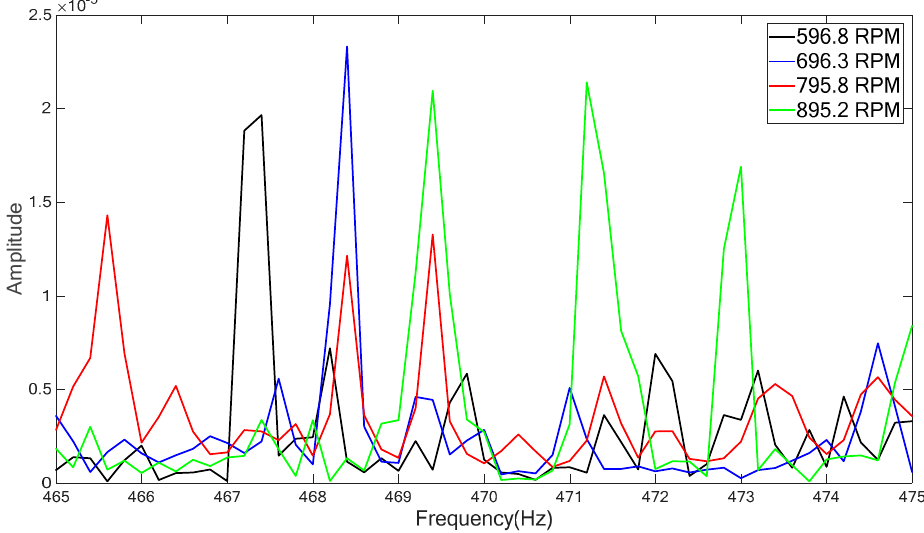
Figure 3. Illustration of spindle rotating speed-unrelated frequency-domain features: Spectrum of vibration signal under different spindle rotating speeds.